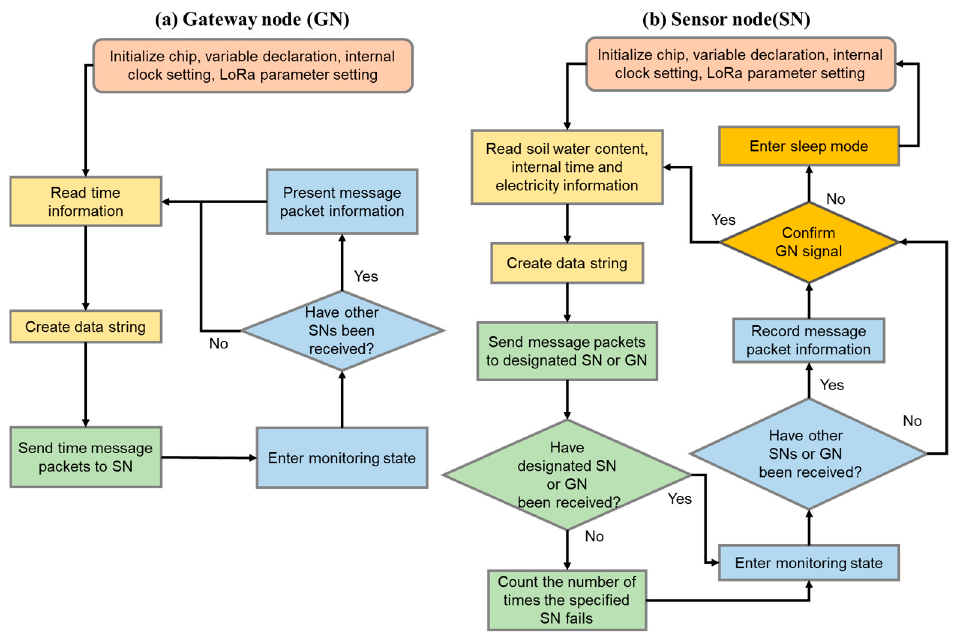
Figure 3. Wireless underground transmission sensor programming flowchart: ( a ) gateway node (GN) process; ( b ) sensor node (SN) process. First stage—pink; second stage—light yellow; third stage—green; fourth stage—blue; fifth stage—deep yellow.